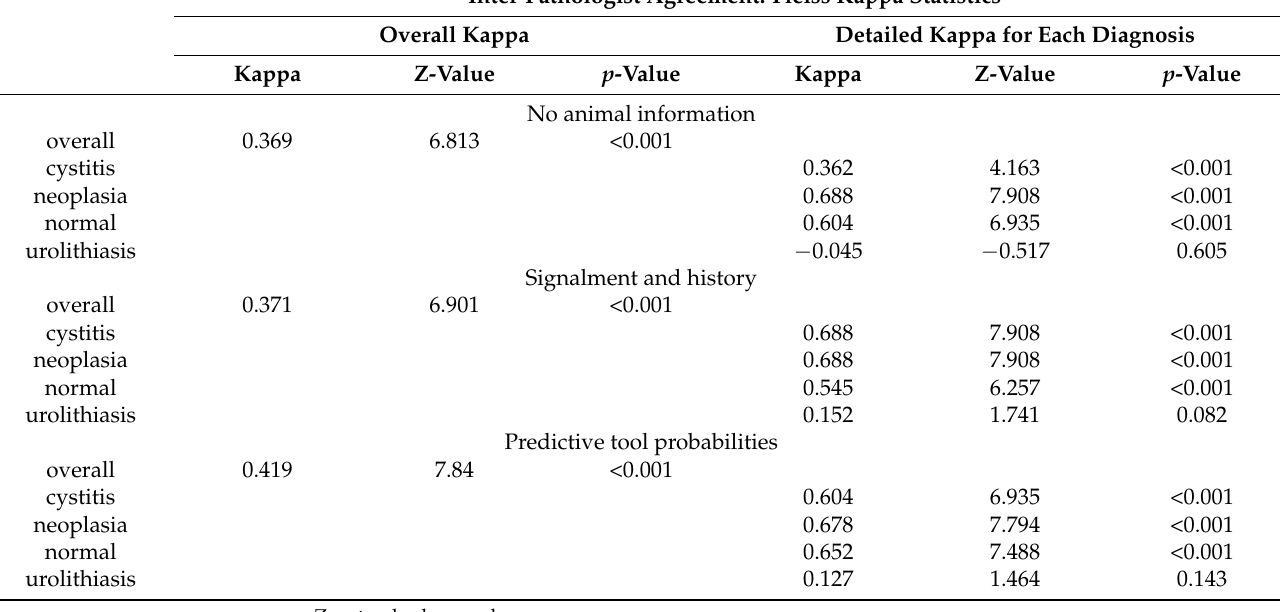
Table 6. Inter-pathologist agreement for the three slide-reading conditions, diagnosing glass slides of canine and feline bladder tissue.